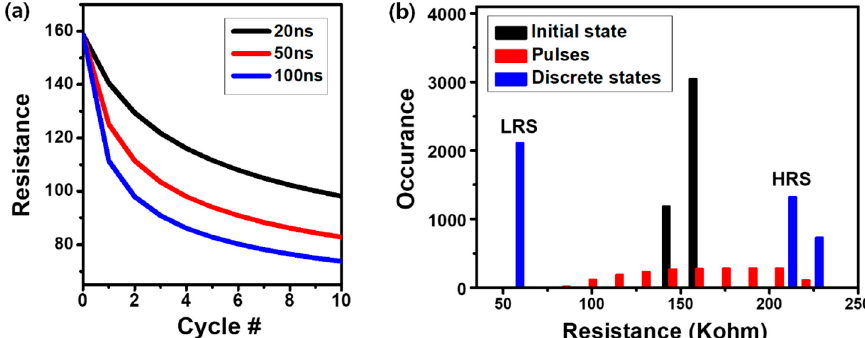
Figure 2. ( a ) Resistance change under pulses with various pulsewidths (20, 50, and 100 ns); and ( b ) resistance distributions of analog memristors in their initial state (black), HRS and LRS states (blue), and gradual transitions induced by various pulses (red).